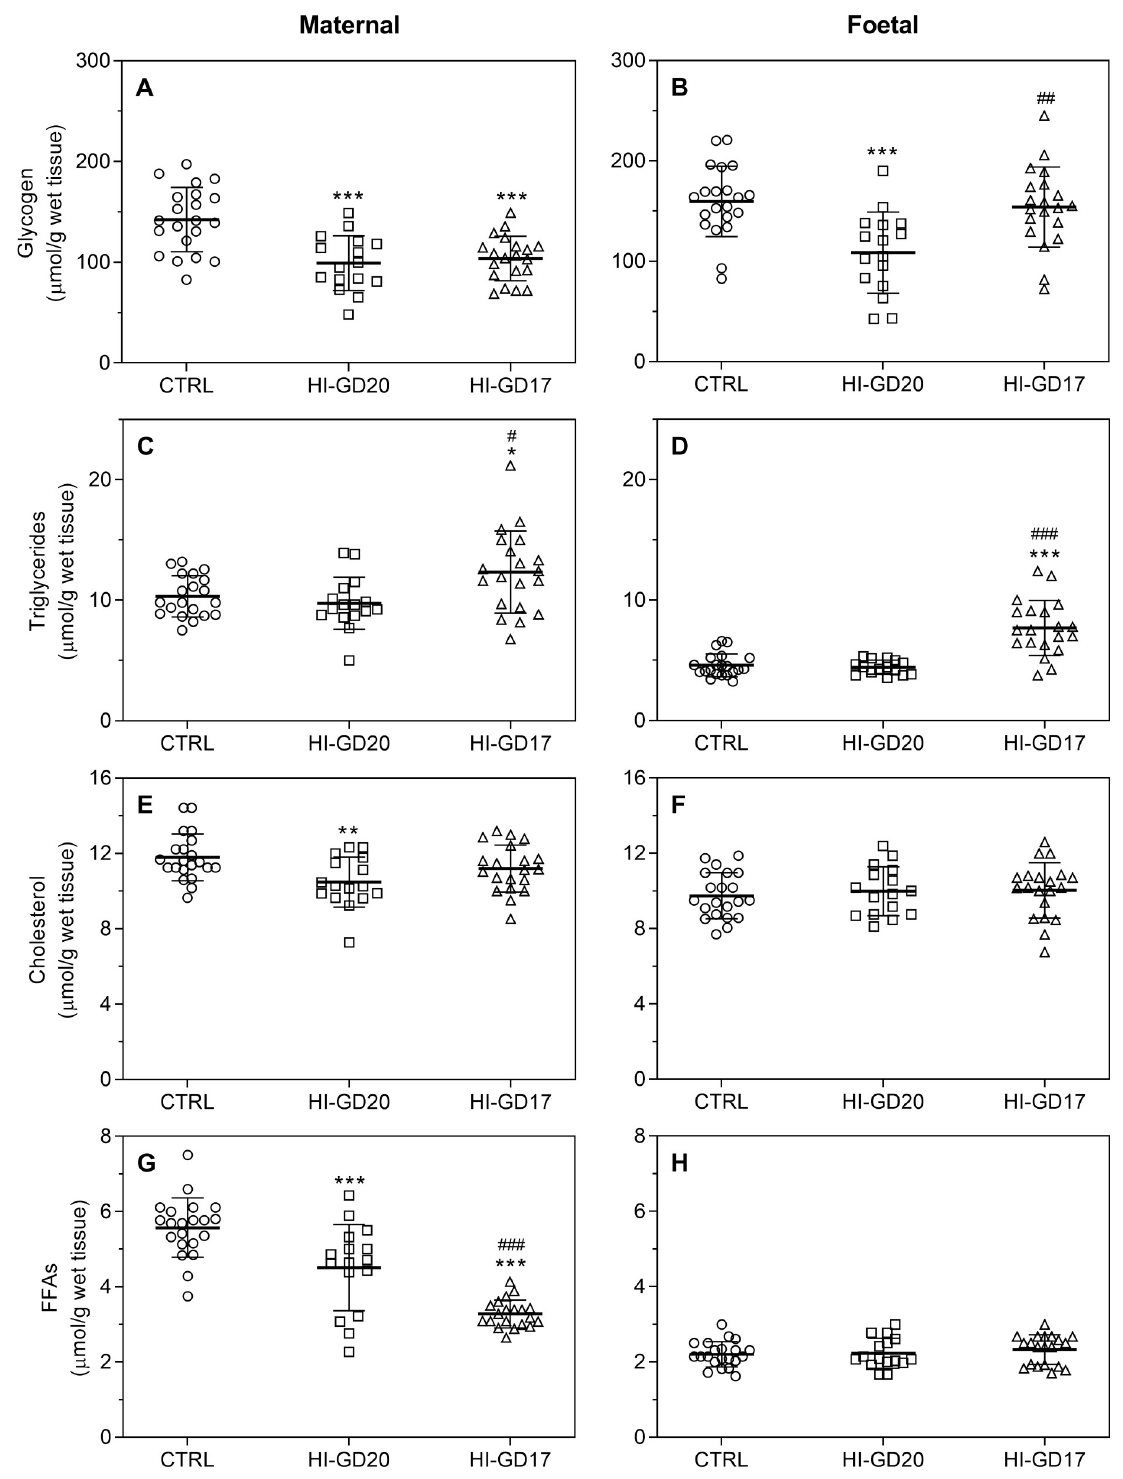
Fig 6. Maternal and foetal liver glycogen and lipid concentrations on GD20, individual (symbols) and means and SD. Left panel: Maternal levels. Right panel : Foetal levels. A+B: Glycogen, C+D: Triglycerides, E+F: Cholesterol, G+H: FFA. Group CTRL, n = 21; group HI-GD20, n = 16; group HI-GD17, n = 20 for all maternal and foetal measurements except for maternal triglyceride levels, where n = 20 in the CTRL group and foetal triglyceride levels, where n = 15 in the HI-GD20 group, as one extreme outlier was identified in each of these groups (29.4 and 10.1 μ mol/g, ROUT test) and excluded. FFAs, free fatty acids. � p < 0.05, �� p < 0.01, ��� p < 0.001 versus group